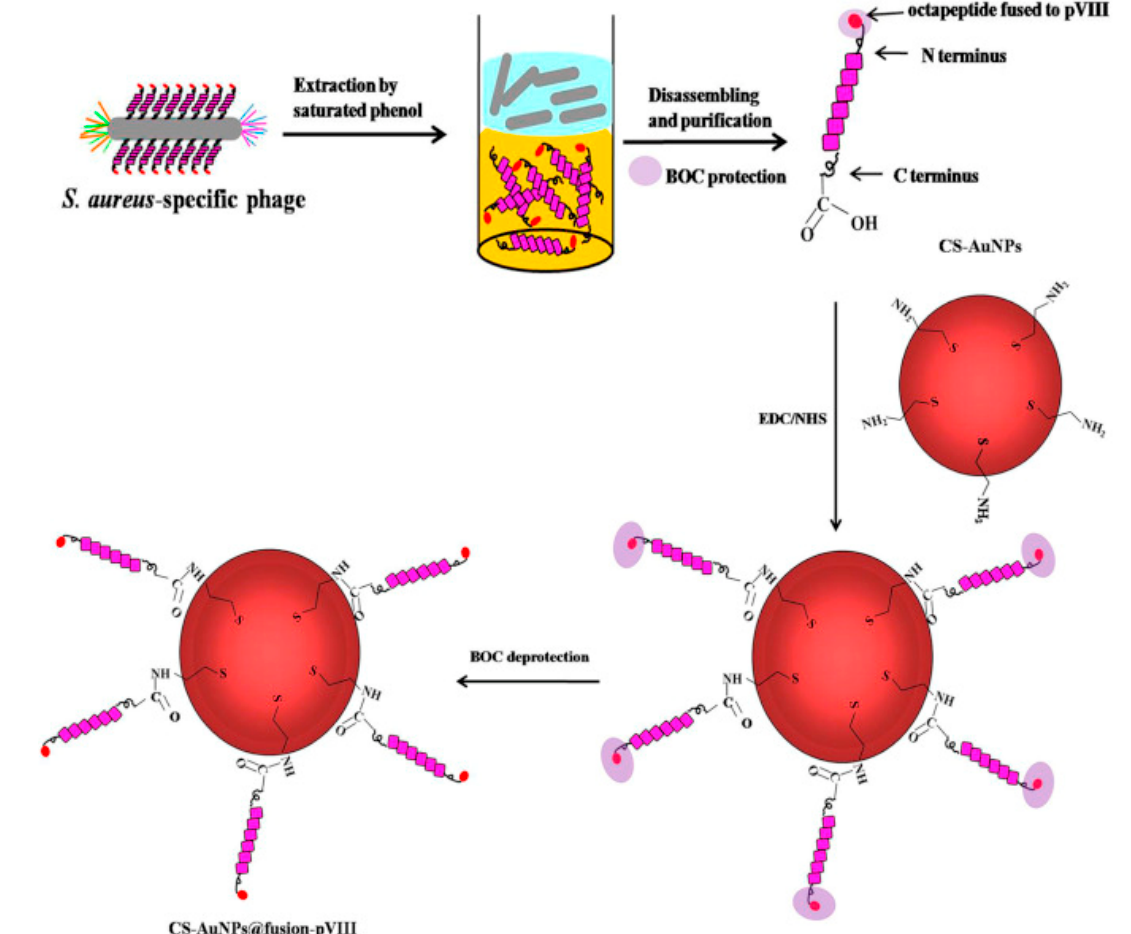
Figure 10. Schematic illustration of the isolation of the pVIII-coated protein fused with an S. aureus - specific octapeptide and the formation of CS-AuNPs@fusion-pVIII [86]. Copyright 2016, Elsevier.